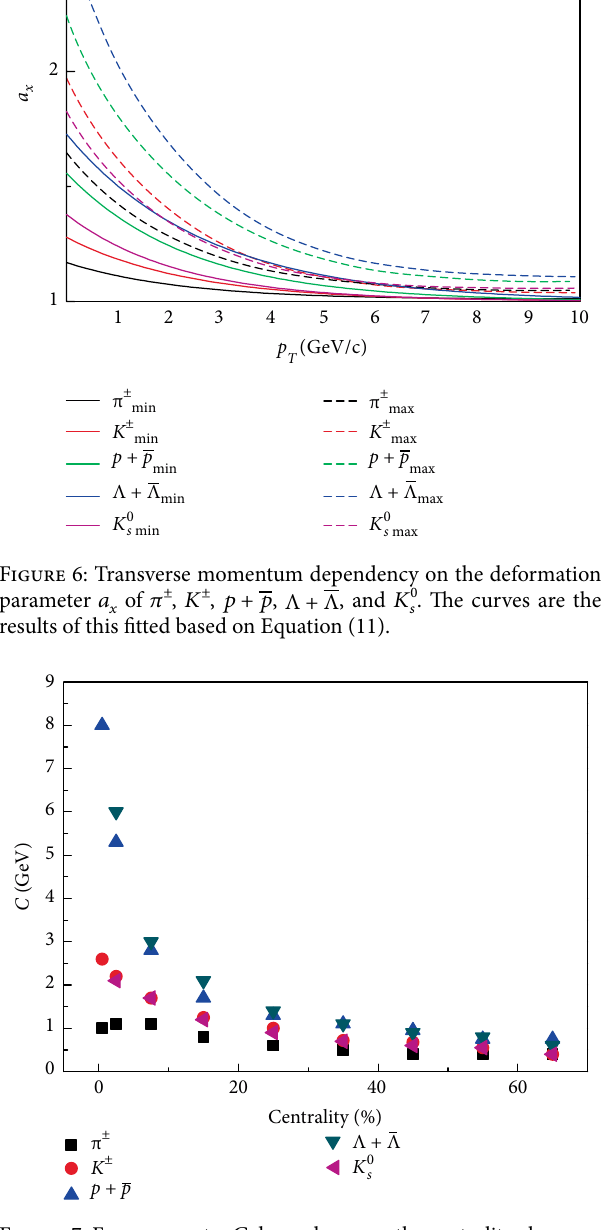
Figure 7: Free parameter 𝐶 dependency on the centrality